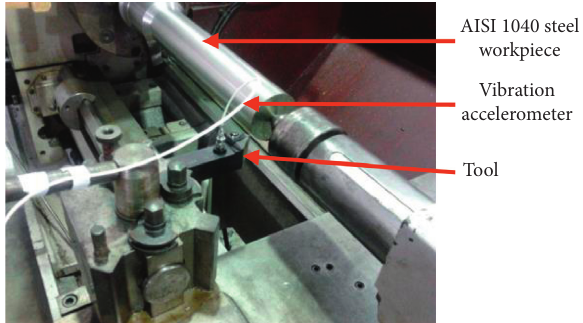
Figure 2: Mounting workpiece on the lathe machine.